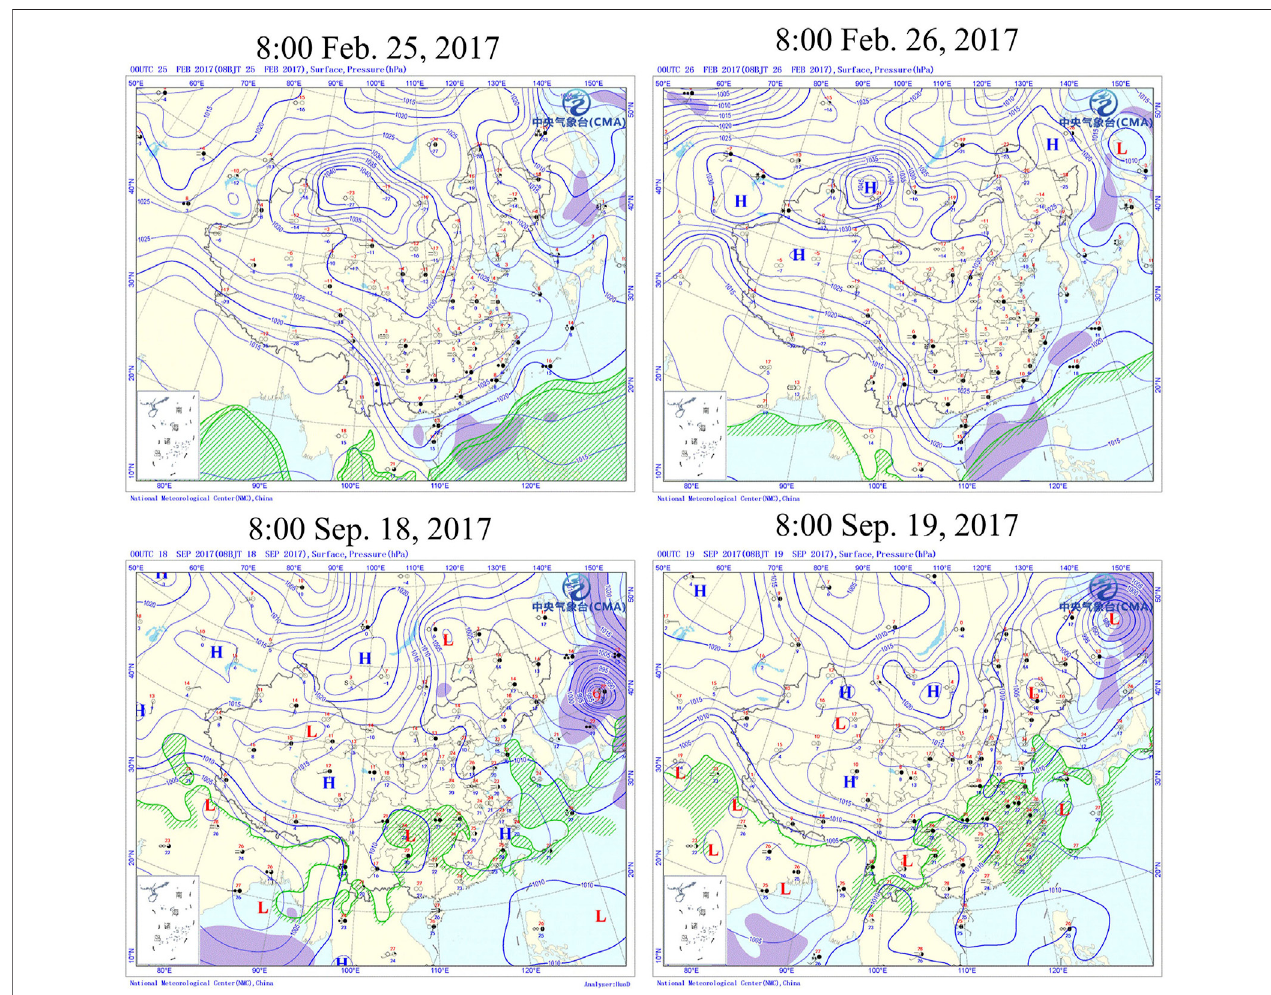
FIGURE 3 | Ground map of typical time in February and September cases (http://www.cma.gov.cn/).